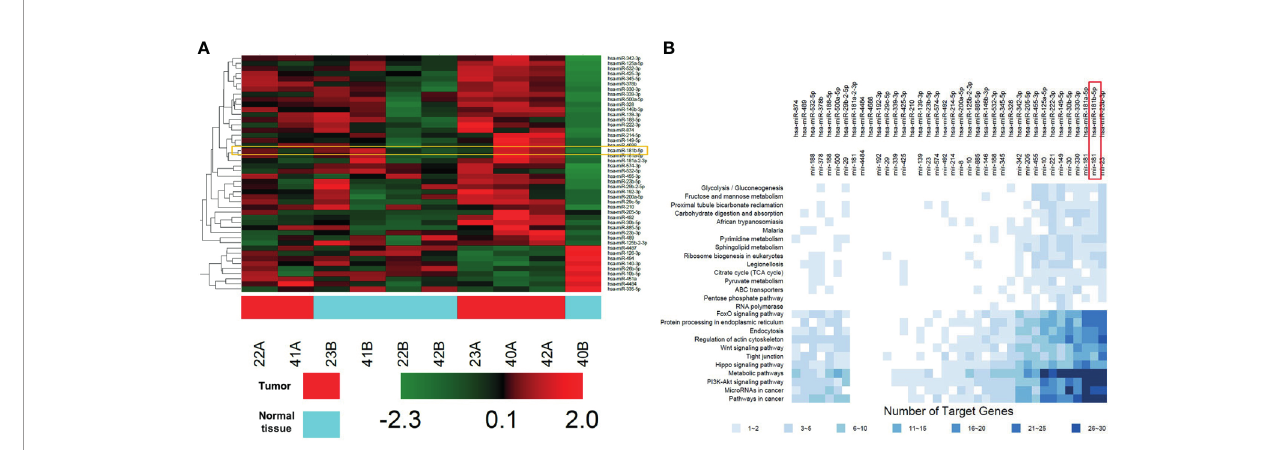
FIGURE 1 | DEGs pro fi ling in GBC tissues. (A) Heat map showing these differentially expressed miRNAs in fi ve non-neoplastic gallbladder tissues (normal tissues) and fi ve gallbladder tumor tissues (tumor tissues). Red represents upregulated genes, green represents downregulated genes. (B) KEGG analysis of protein targets of these DEGs.